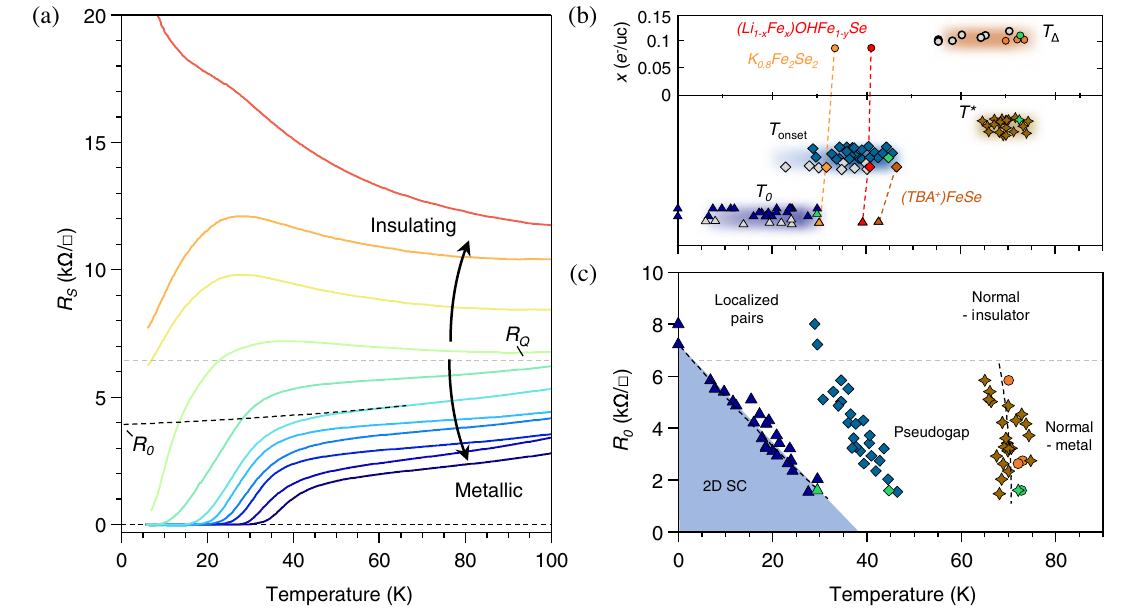
FIG. 4. Disorder-driven superconductor-insulator transition in single-layer FeSe = SrTiO 3 . (a) R s for a selection of single-layer FeSe = SrTiO 3 films. The residual resistance R 0 for each curve is determined by an extrapolation of the normal state data above T (cid:3) (black dashed line). (b) Extracted characteristic temperatures of single-layer FeSe = SrTiO 3 . Marked symbols indicate T 0 (triangles), T (diamonds), T (cid:3) (stars), and T Δ (circles) versus x (Luttinger volume) as measured in situ by this study (solid colored symbols) and from the literature (gray filled symbols). T 0 , T , and T (cid:3) values are offset along the Y axis for clarity. Literature data for T 0 and T onset taken from capped single-layer FeSe = SrTiO 3 films. Bright green symbols indicate values for the sample presented in Figs. 1 – 3. ARPES gap values and doping levels from the literature are reported from Refs. [1,3,4,14,30 – 32]. Ex situ transport data from Refs. [2,10 – 13]. T T , and T Δ values are also plotted for bulk compounds K 0 Fe 2 Se 2 (orange, solid line), ð Li 1 − x Fe x Þ OHFeSe (red, solid line), and 0 , onset . 8 ð TBA þÞ FeSe (brown, solid line). (c) R T T , T (cid:3) , and T Δ for films measured in situ for this work. Extended data for T Δ and 0 versus 0 , onset T (cid:3) are provided in Supplemental Material, Sec. IV